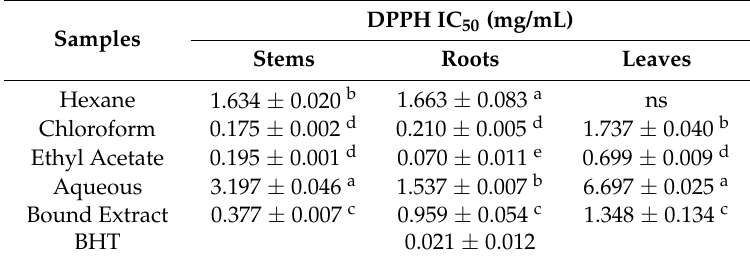
Table 2. DPPH radical scavenging activity of Phal. Sogo Yukidian “V3” cultivar extracts in terms of IC 50 values.